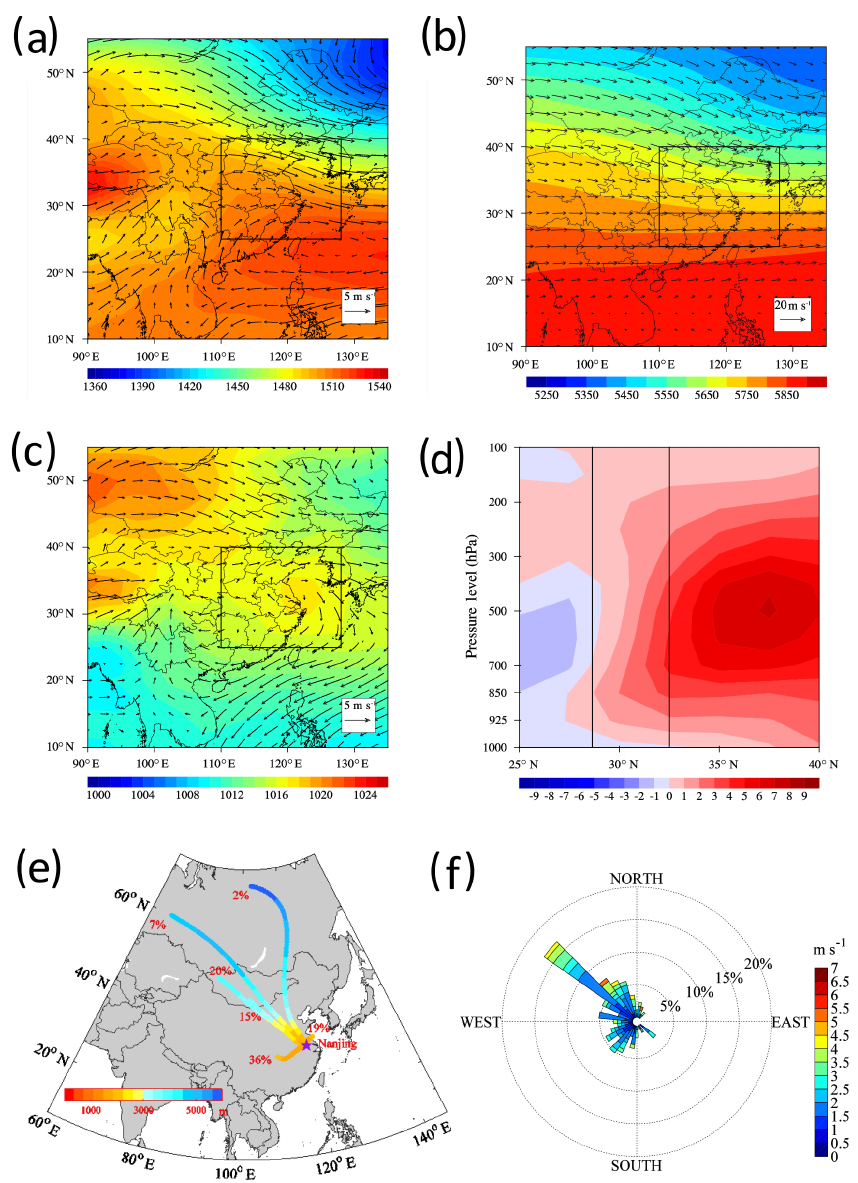
Figure 7. Weather condition in Pattern 1. (a) 850hPa geopotential height field and wind field, (b) 500hPa geopotential height field and wind field, (c) sea level pressure field and 1000hPa wind field, (d) height-latitude cross-sections of vertical velocity (unit: 10 − 2 Pas − 1 ) averaged over longitude of 110–128 ◦ E, (e) 72h backward trajectory ending at a height of 1500m, and (f) observation wind rose plots in Nanjing. In (a–c) , the highlighted boxes denote the study area (i.e., the YRD). In (d) , the black rectangular region represents the 16 cities in the YRD (28.6–32.5 ◦ N). In (e) , the purple marker indicates the location of Nanjing (32 ◦ N, 118.8 ◦ E). These data represent averages for all days corresponding to Pattern